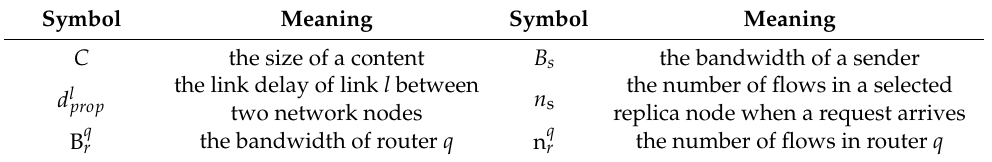
Table 2. The meaning of